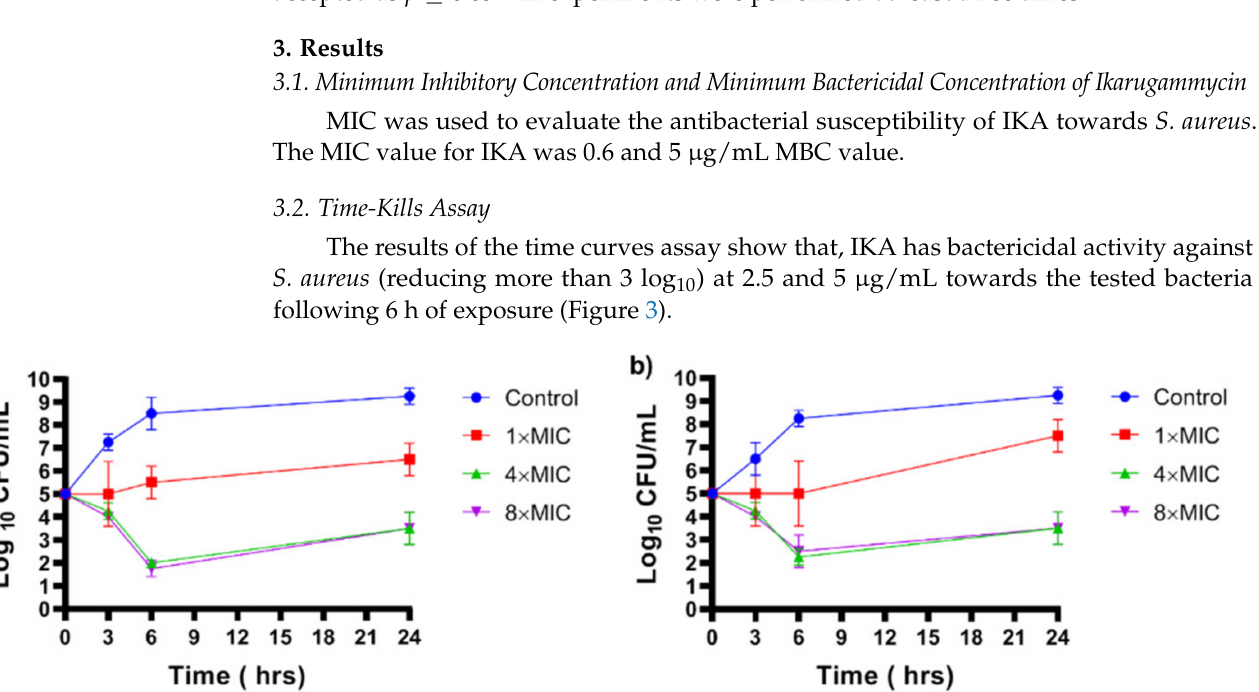
Figure 3. Time–kill curves of S. aureus 15AL ( a ) and S. aureus F53 B ( b ) following exposure with IKA for 24 h at 37 ◦ C. For each time point, an aliquot of bacteria was taken out, serially diluted and plated for colony counting. The experiments were performed in triplicates and each value represents the mean ± standard deviation of log CFU/mL of